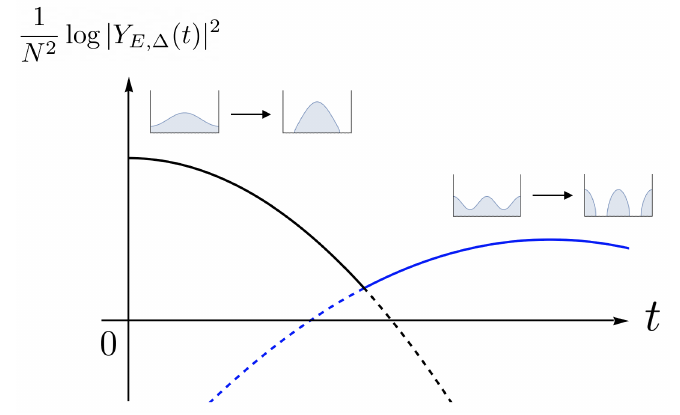
Figure 9 . The discussion for E + β H ∆ 2 < E c has a simple continuation into the deconfined regime E + β H ∆ 2 > E c . For example, the saddle point which has a cos 2 θ variation continues into a two-cut gapped solution. The basic structure of the spectral form factor can remain the